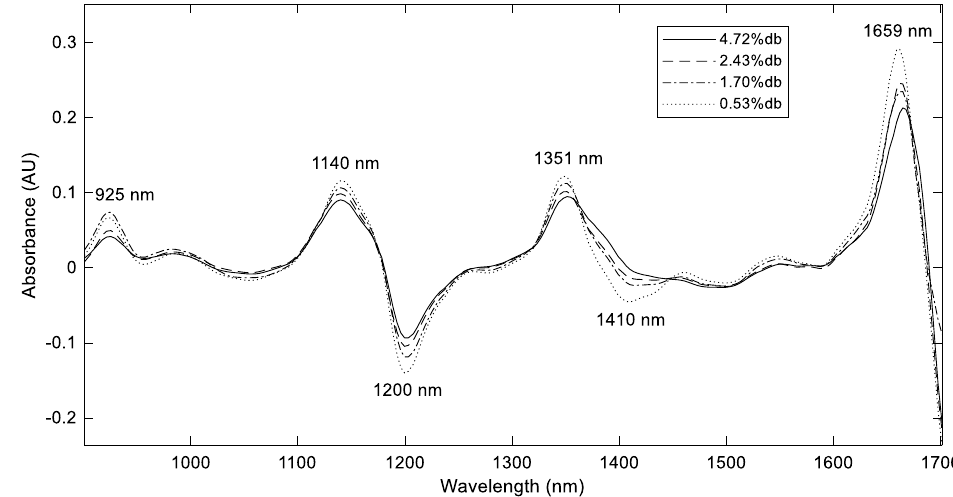
Fig. 5. Mean spectra of rubber sheets with di®erent moisture contents preprocessed by the ¯rst derivative.